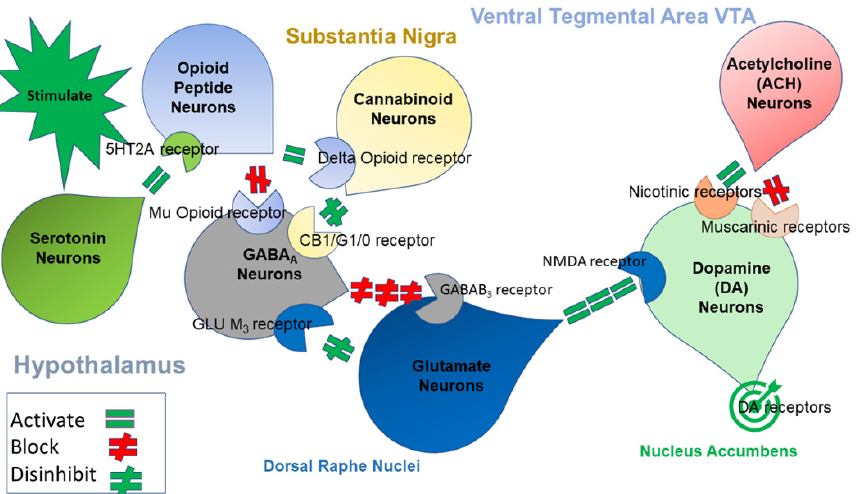
Figure 1. This cartoon figure illustrates some of the interactions of several neurotransmitter pathways in the Brain Reward Cascade (BRC) system. Environmental stimulation in the hypothalamus causes the release of serotonin, which, in turn, via, for example, 5HT-2a receptors activates (green equals sign) opioid peptides, releasing them into the hypothalamus. The opioid peptides have two distinct effects via two different opioid receptors. The first inhibits (red hash sign) through the mu-opioid receptor (possibly via enkephalin), which projects to the substantia nigra GABAA neurons, and the second stimulates (green equal sign) cannabinoid neurons (e.g., 2-archydonoglcerol and anandamide) through beta-endorphin-linked delta receptors, which, in substantia nigra, inhibit GABAA neurons. Activated cannabinoids, mostly 2-archydonoglcerol, can also disinhibit (red hash sign) substantia nigra GABAA neurons indirectly by activating G1/0-coupled CB1 receptors. Similarly, dorsal raphe nuclei (DRN) glutamate neurons can disinhibit substantia nigra GABAA neurons indirectly through the activation of GLU M3 receptors (red hash sign). Stimulated GABAA neurons will powerfully (red hash signs) inhibit VTA glutaminergic drive via GABAB 3 neurons. VTA glutamate neurons project to dopamine neurons through NMDA receptors (green equals sign), where they preferentially